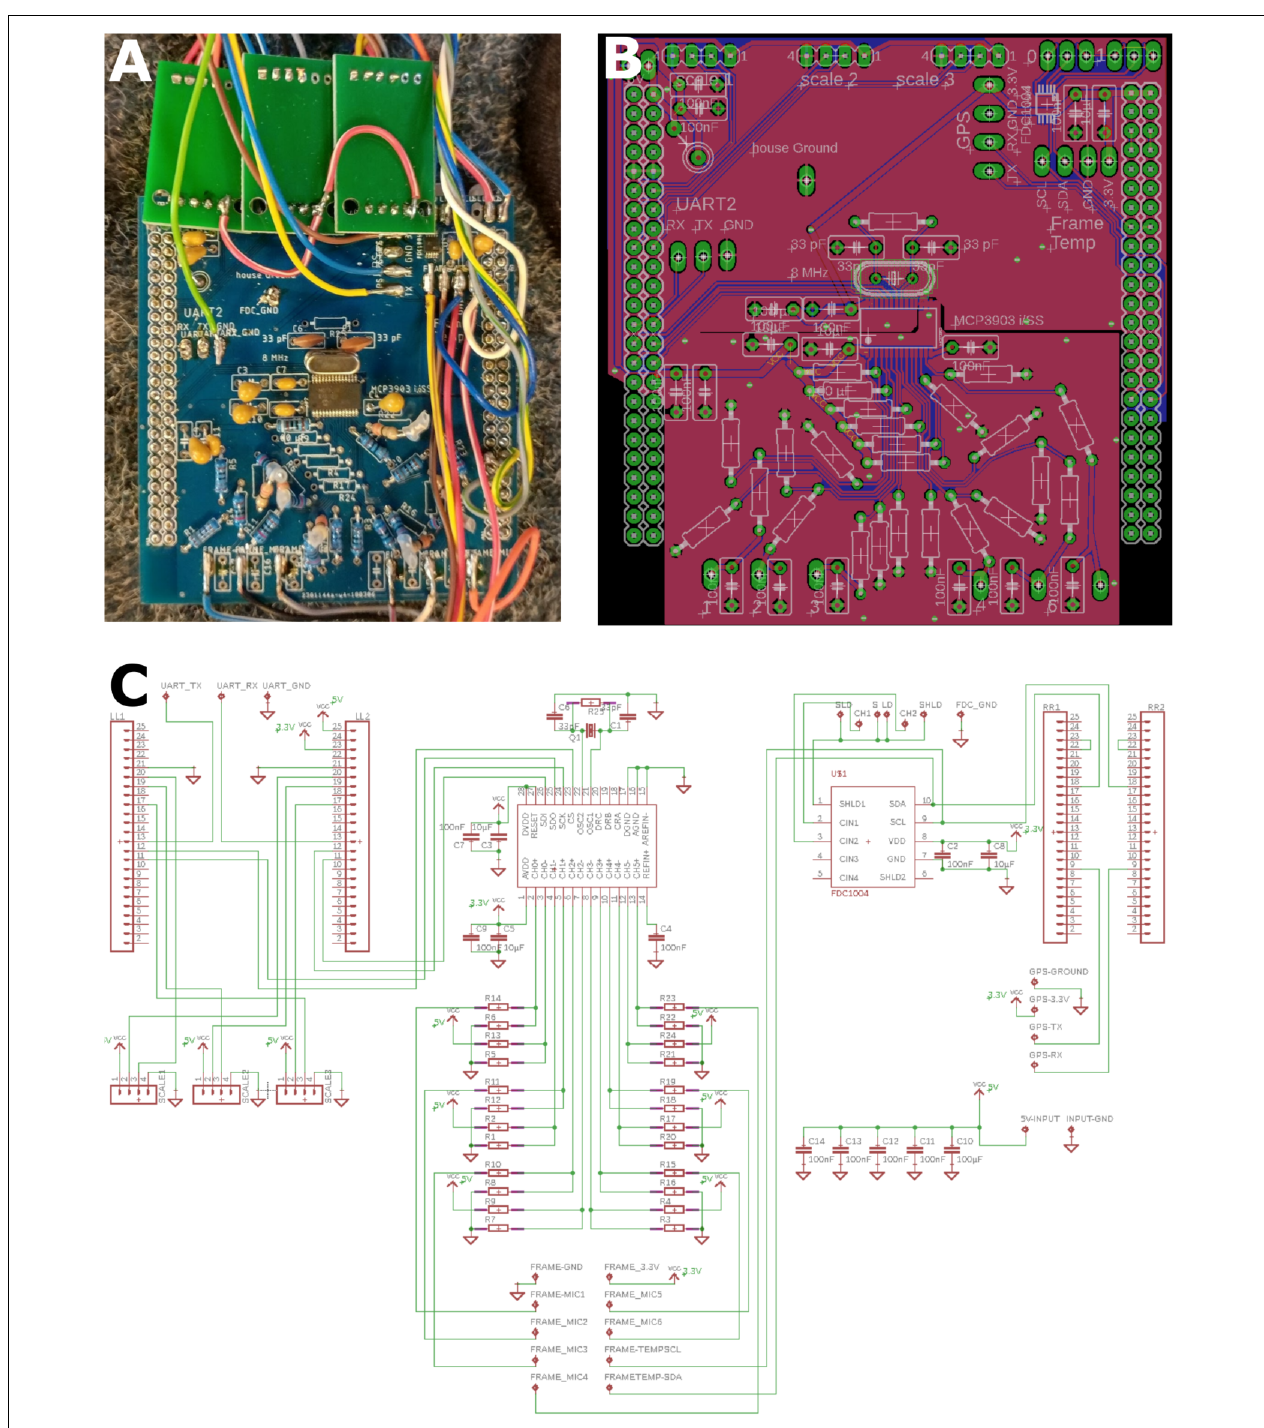
FIGURE 2 | Central recording device. Inputs (ESF probes, Temperature, Humidity, Scale, GPS and entrance activity; Figure 1 ) were connected to the central board as well as to a SD card writer to save all data. The custom-made board was plugged onto a STM32 developer board. (A) Photograph of one unit. Large pin rows left and right connected to the STM32 board below. The green printed circuit boards (PCBs) on the bottom house the scale instrumental amplifiers and associated ADCs (analog-digital converters). The central SMD chip (MCP3903, Microchip, AZ, USA) digitized the analog ESF signals (middle of PCB). (B) PCB schematic diagram of the board in (A) . Note the split ground plane along the horizontal middle axis. The lower segregated ground plan isolated the upper digital traces from the sensitive analog ESF signals. (C) Circuit diagram of (A) and (B) .